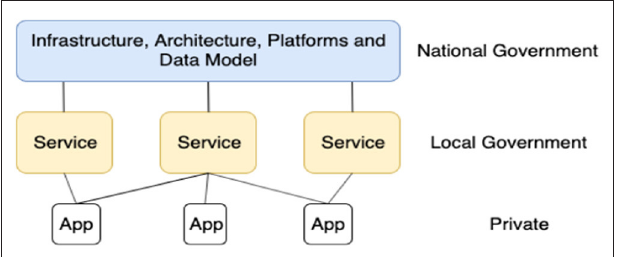
FIGURE 3 | Role of stakeholders in creating cities as a